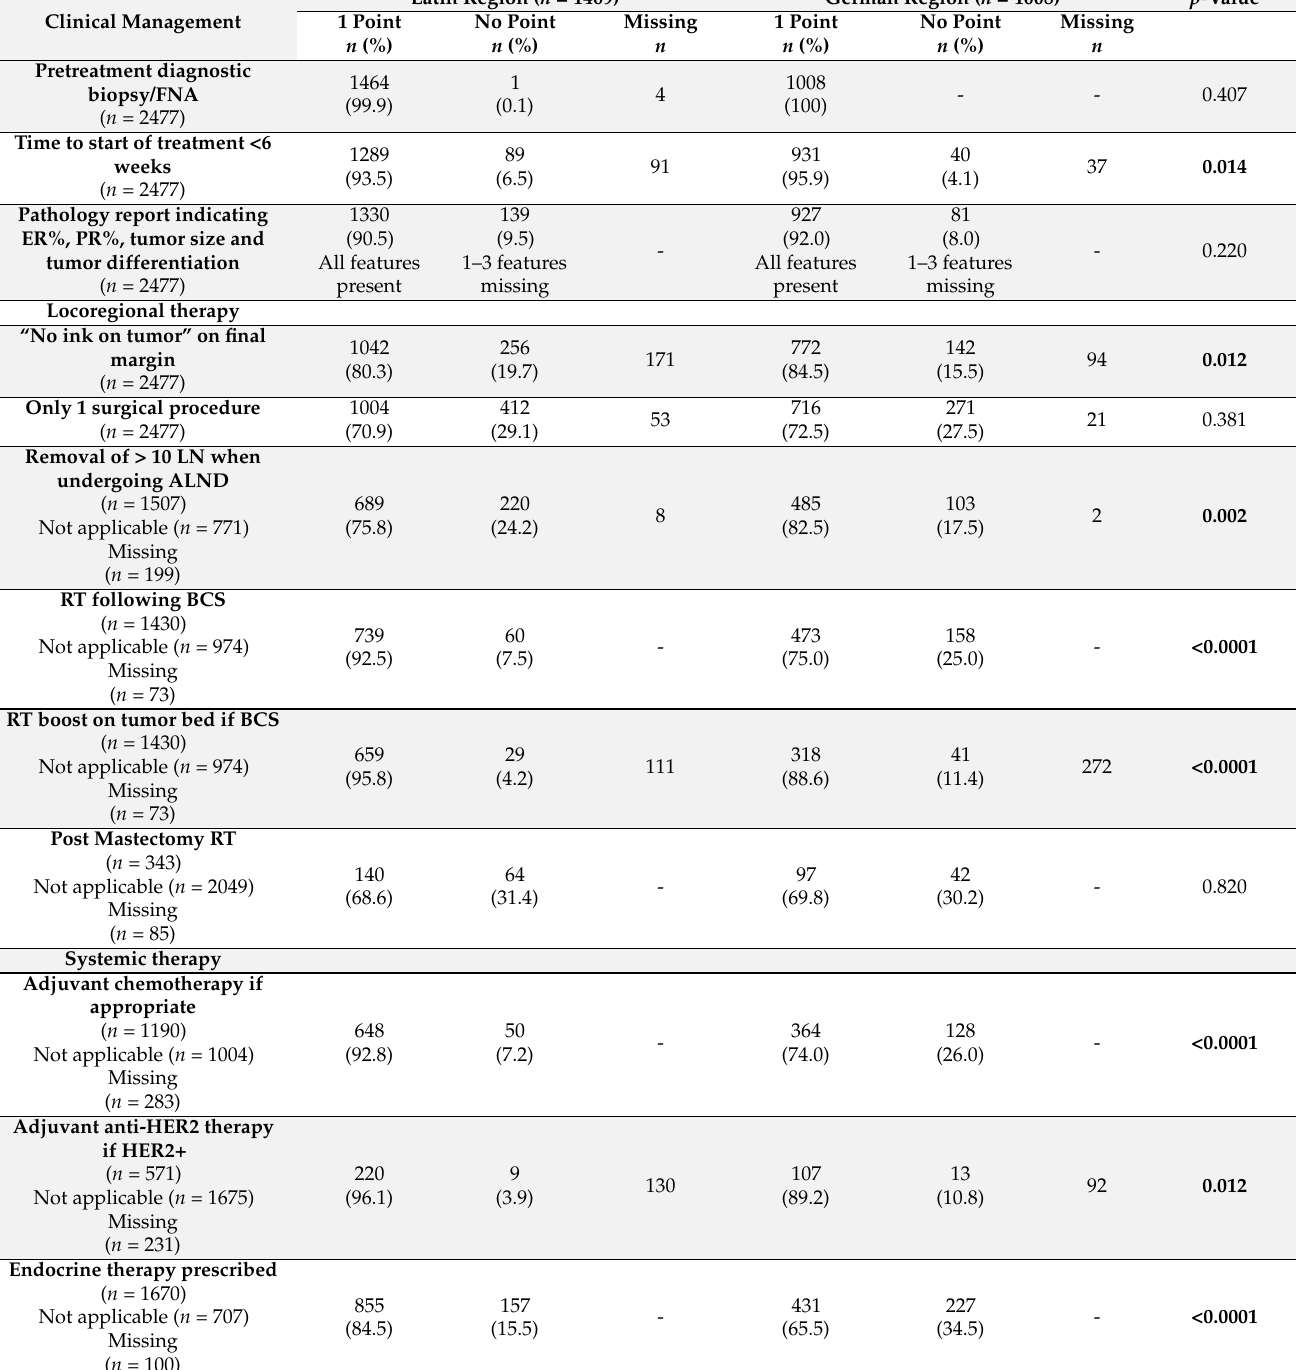
Table 2. Quality-of-care indicators stratified by linguistic-geographic